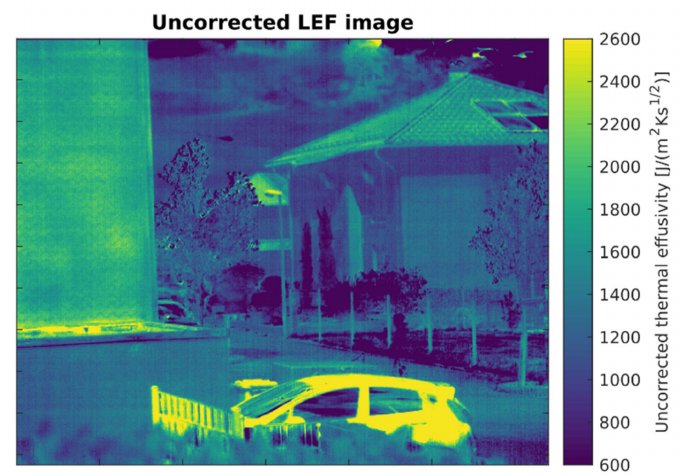
Figure 8. Linear effusivity fit image.